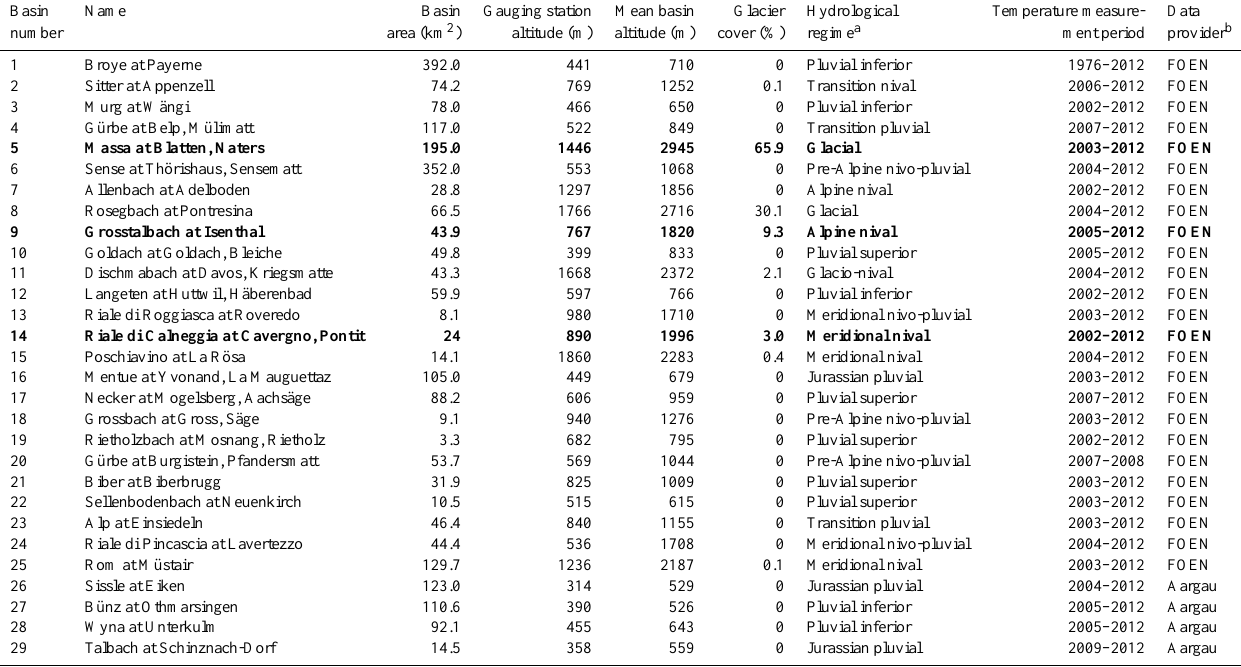
Table 3. Physiographic properties of the 29 selected hydrological catchments in Switzerland. The three watersheds indicated in bold are not used for the model